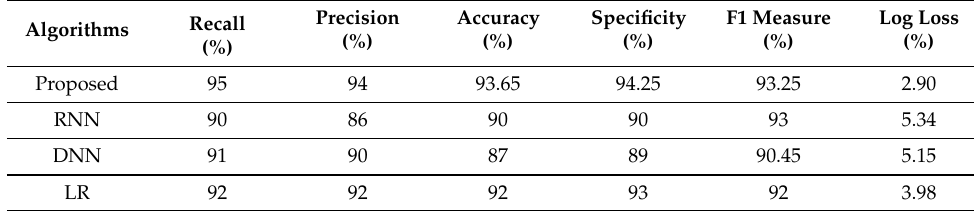
Table 6. Attack Classification Analysis: SYN DDoS